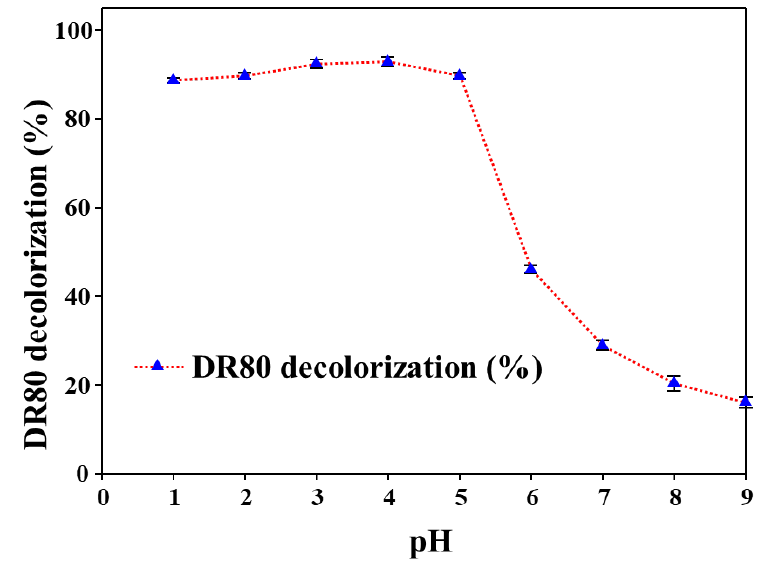
Figure 9. Effect of pH on removal of the DR80 by HNTs-Fe 3 O 4 -CTs-S-S-Laccase in the presence of the redox mediator ABTS.